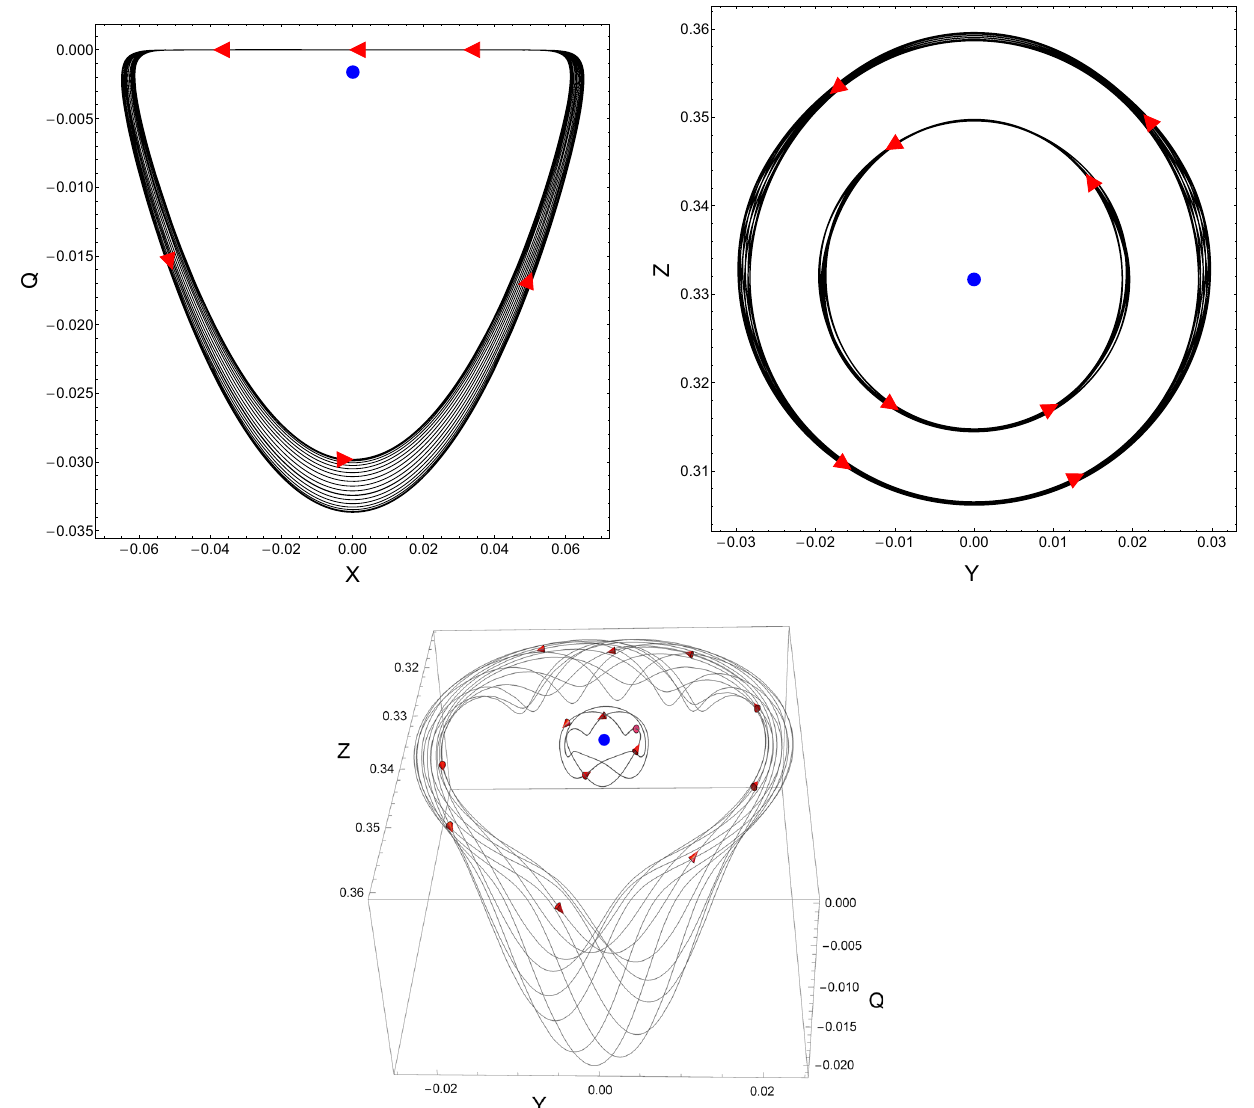
plot) and Y ES = 0, Z ES = 0 . 3317 (right plot). The lower panel rep- resents numerical simulation of the solution in 3D subspace ( Z , Q , Y ) for the same model parameters as the upper plots. The initial values for numerical integration has been chosen as X 0 = Y 0 = 0, Z 0 = 0 . 36, Q 0 = − 0 . 0213 (outer orbits) and Z 0 = 0 . 337, Q 0 = − 0 . 00394